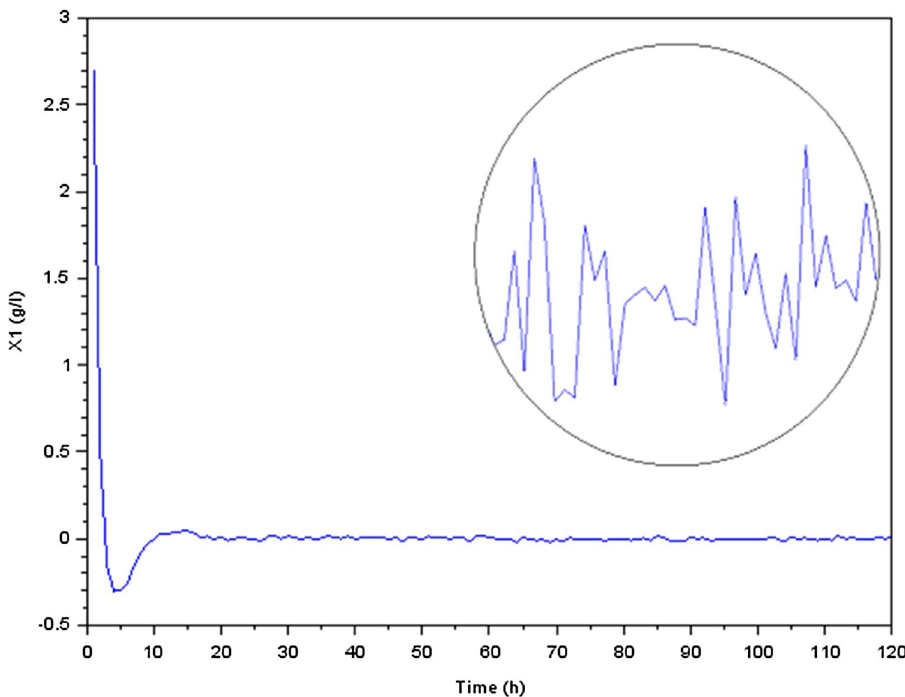
Figure 5. Variation of acidogenic methanogenic bacteria concentration X 1